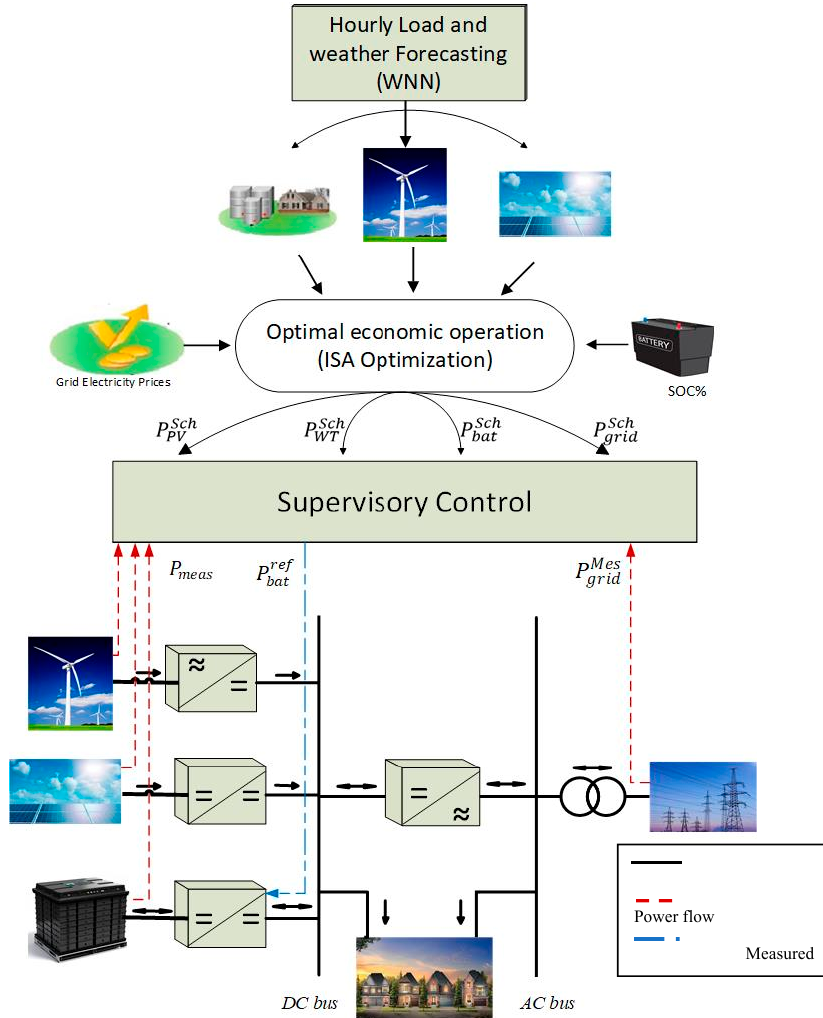
Figure 2. Energy management system (EMS) and control for the proposed MG. WNN: wavelet neural network; ISA: interior search algorithm.